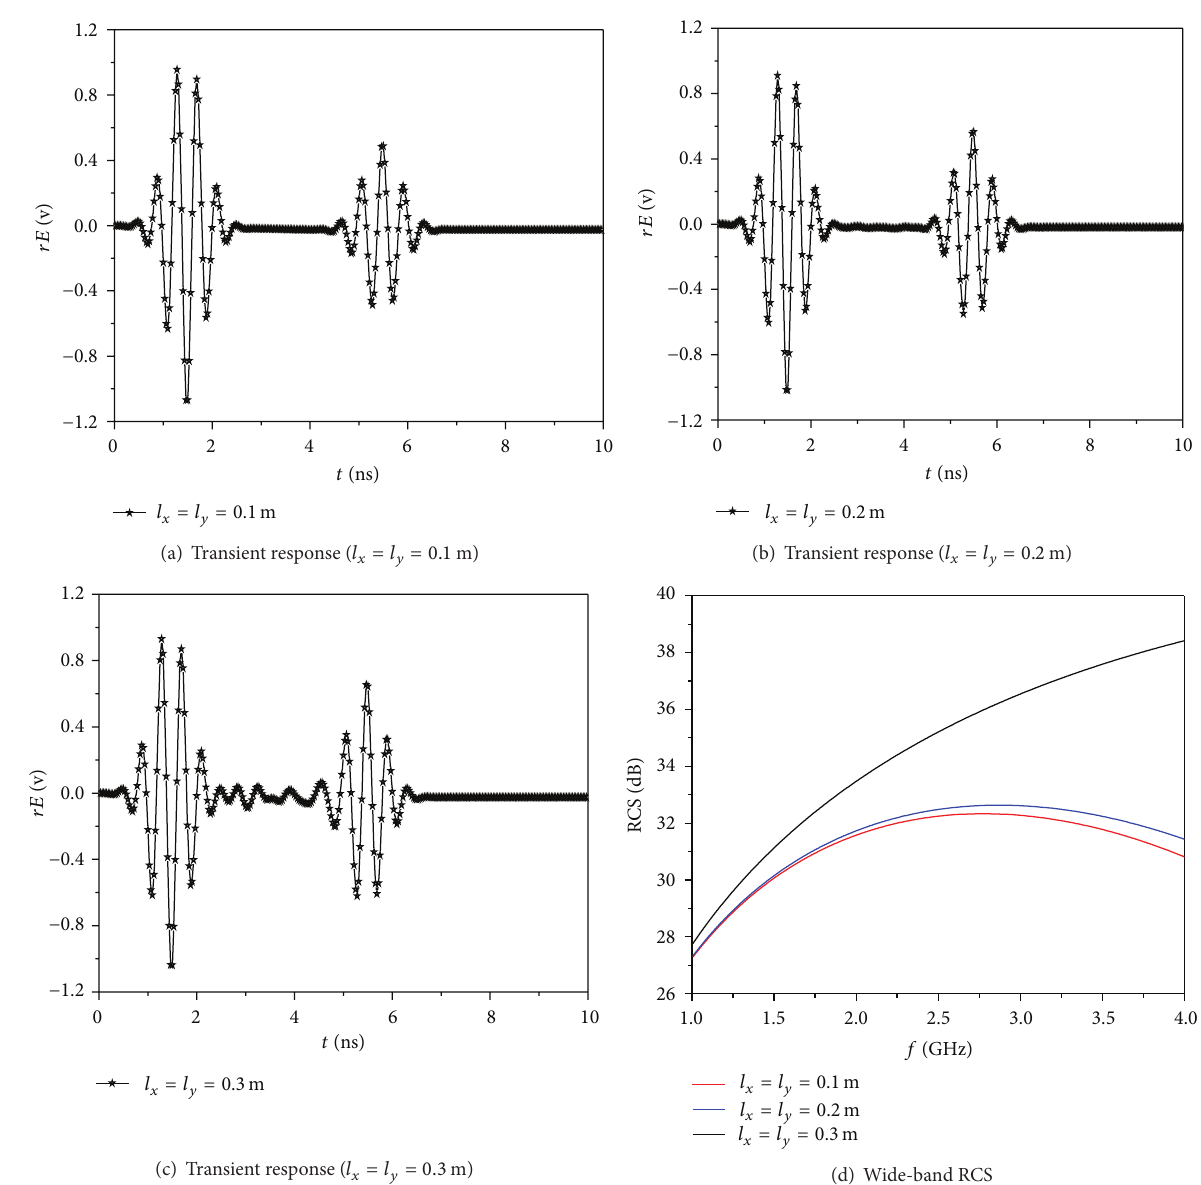
Figure 5: Scattering from the 2D PEC rough surface in the specular direction for different correlation lengths.